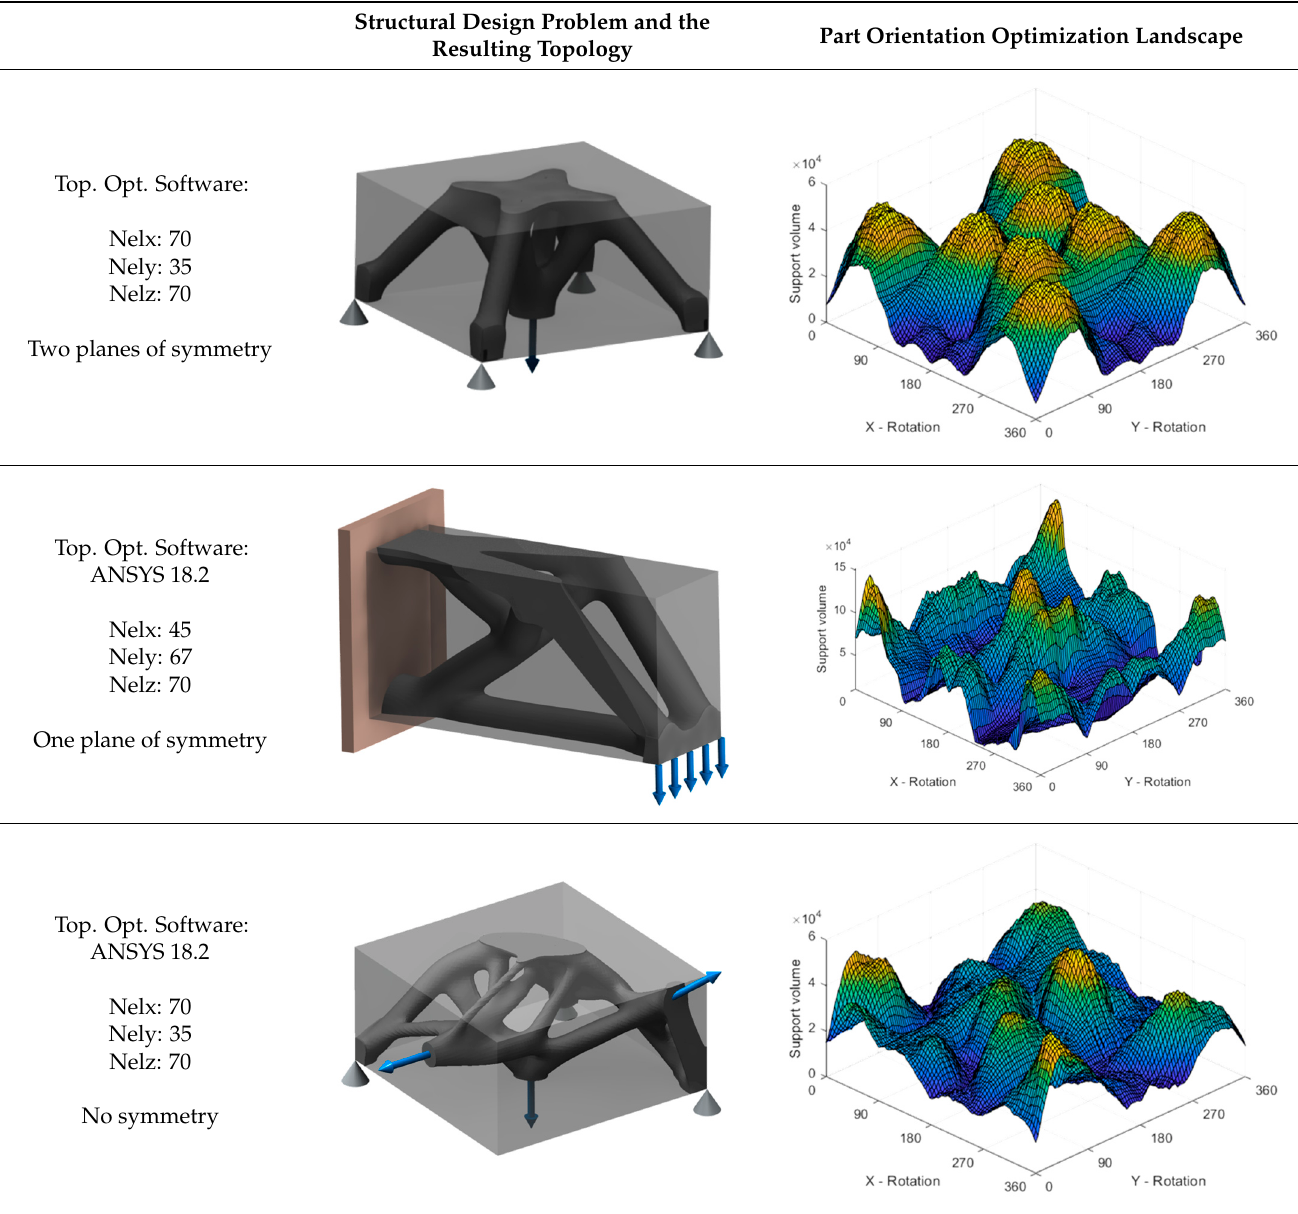
Table 2. Part orientations that minimize and maximize the required support volume with surface angle visuals of the minimum orientation.